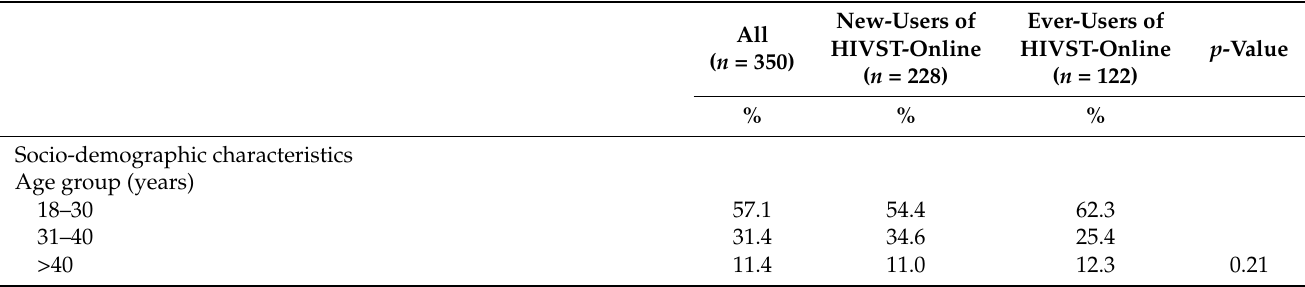
Table 1. Background characteristics of the